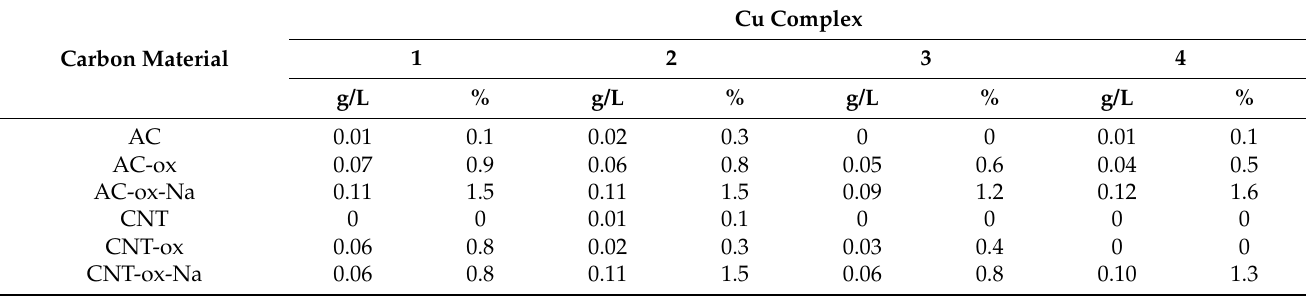
Table 2. Metal loading of Cu on the carbon materials a